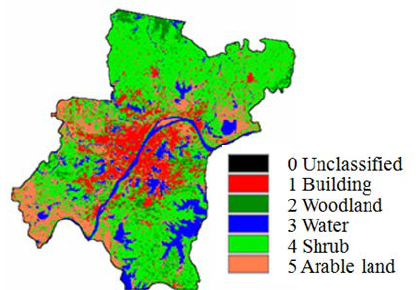
Fig.1 Classification result of Wuhan